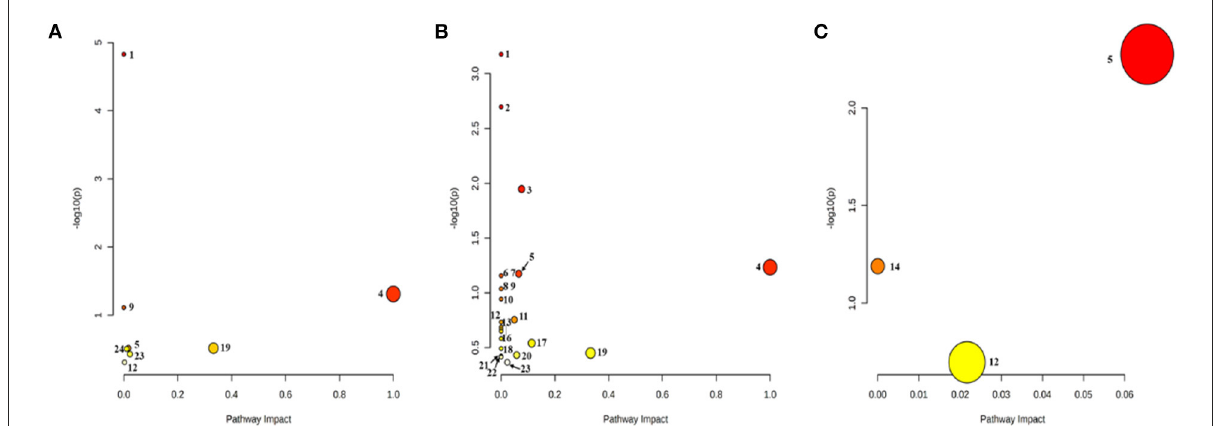
FIGURE7 Bubble diagram of the metabolic pathway. (A) Control vs. Low-dose; (B) Control vs. High-dose; (C) Low-dose vs. High-dose. (1) Biosynthesis of unsaturated fatty acids; (2) Aminoacyl-tRNA biosynthesis; (3) Arginine biosynthesis; (4) Linoleic acid metabolism; (5) Glycerophospholipid metabolism; (6) D-Glutamine and D-glutamate metabolism; (7) Nitrogen metabolism; (8) Valine, leucine, and isoleucine biosynthesis; (9) Taurine and hypotaurine metabolism; (10) Biotin metabolism; (11) Histidine metabolism; (12) Purine metabolism; (13) Pantothenate and CoA biosynthesis; (14) Ether lipid metabolism; (15) beta-Alanine metabolisms; (16) Lysine degradation; (17) Alanine, aspartate, and glutamate metabolism; (18) Glyoxylate and dicarboxylate metabolism; (19) Arachidonic acid metabolism; (20) Arginine and proline metabolism; (21) Pyrimidine metabolism; (22) Valine, leucine, and isoleucine degradation; (23) Primary bile acid biosynthesis; (24) Amino sugar and nucleotide sugar